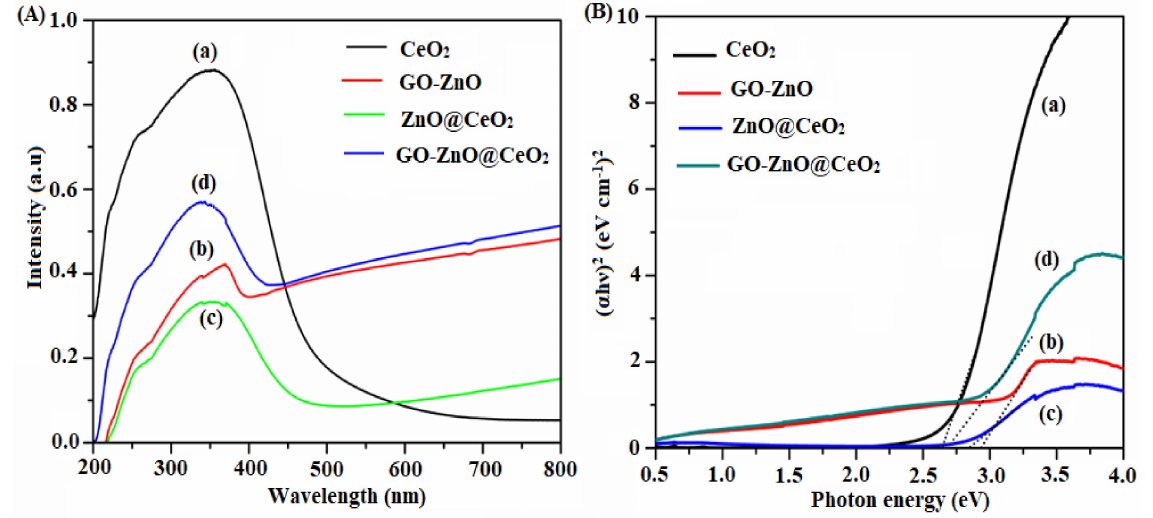
Figure 4. ( A ) UV–visible absorbance spectra and ( B ) energy band gap of ( a ) CeO 2 , ( b ) GO-ZnO, ( c ) ZnO@CeO 2 and ( d ) GO-ZnO@CeO 2